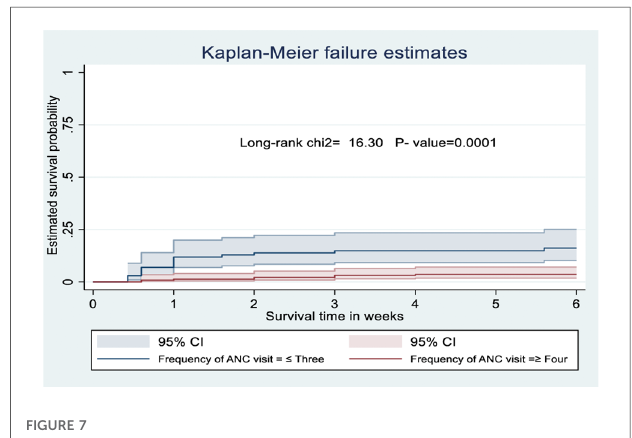
FIGURE 7 Kaplan-Meier curve showing the survival probability of developing puerperal sepsis among postnatal women based on the frequency of ANC visit.